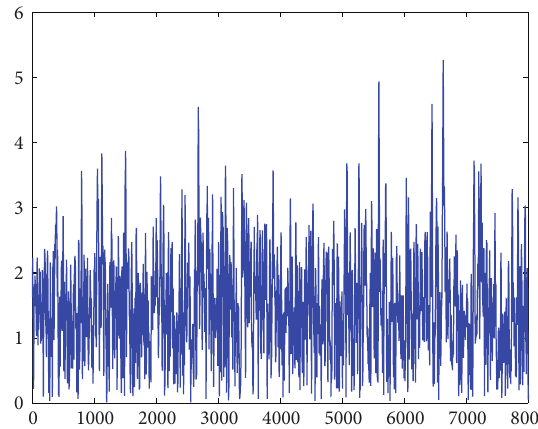
Figure 8: Rayleigh distribution